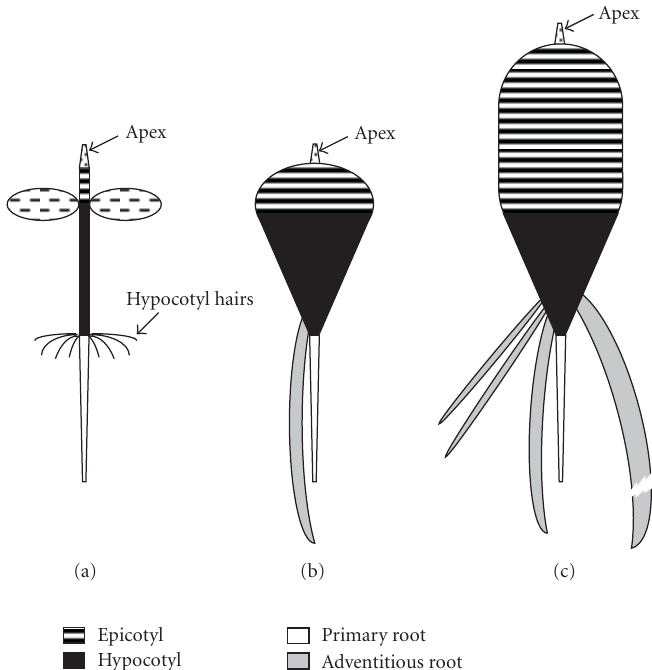
Figure 2: Schematic representation of the development of P. palinuri plants from seedling stage up to the beginning of rhizome formation: (a) seedling; (b) very young plants with hypocotyl elongating into a small cone and tuberizing epicotyl; (c) young plant with tuberized epicotyl elongating to form a rhizome and many adventitious roots emerging at the base of the hypocotyl